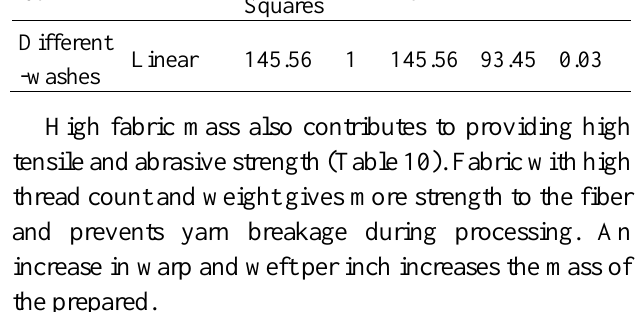
Statistical Analysis of Mass loss at 6000 rubbing cycles Source